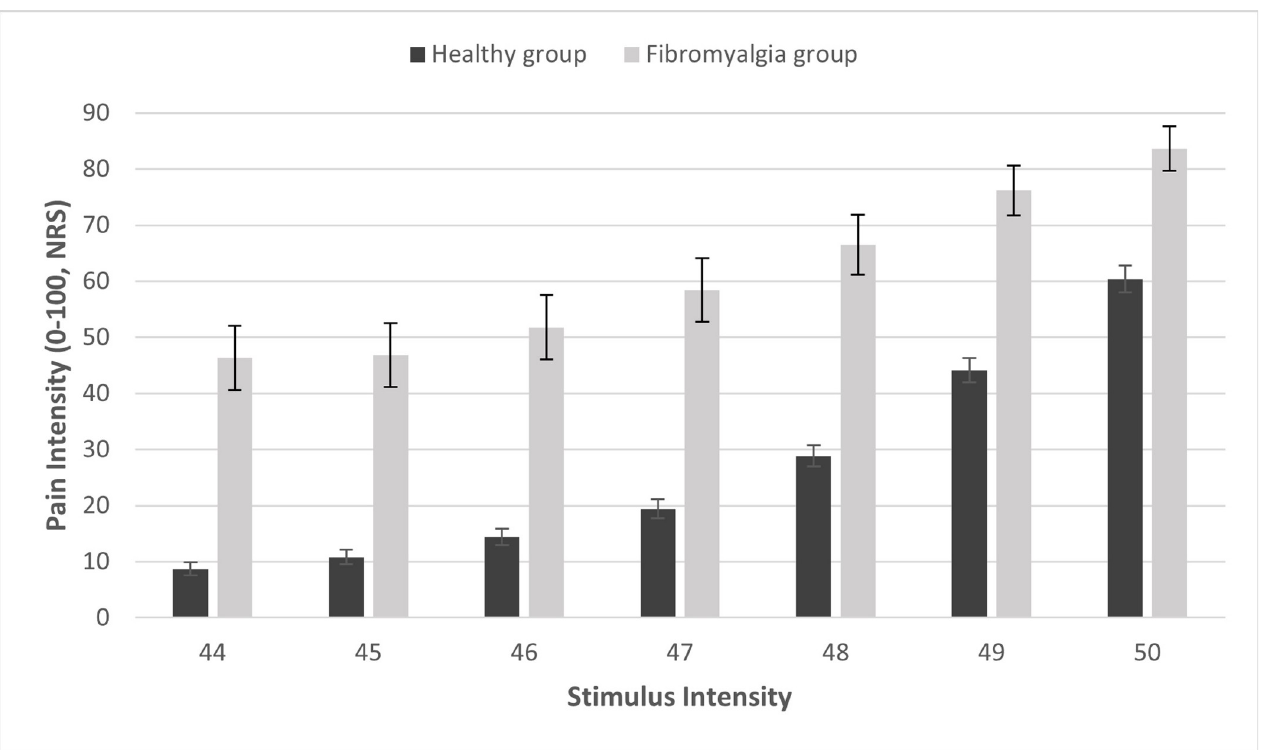
Fig 1. Mean pain scores in response to the 7 FAST stimulus intensities. Black and grey bars represent the average pain scores in response to the 7 repetitions of the stimulus at each intensity, for healthy and Fibromyalgia patients, respectively. Error bars represent the standard error of the mean.